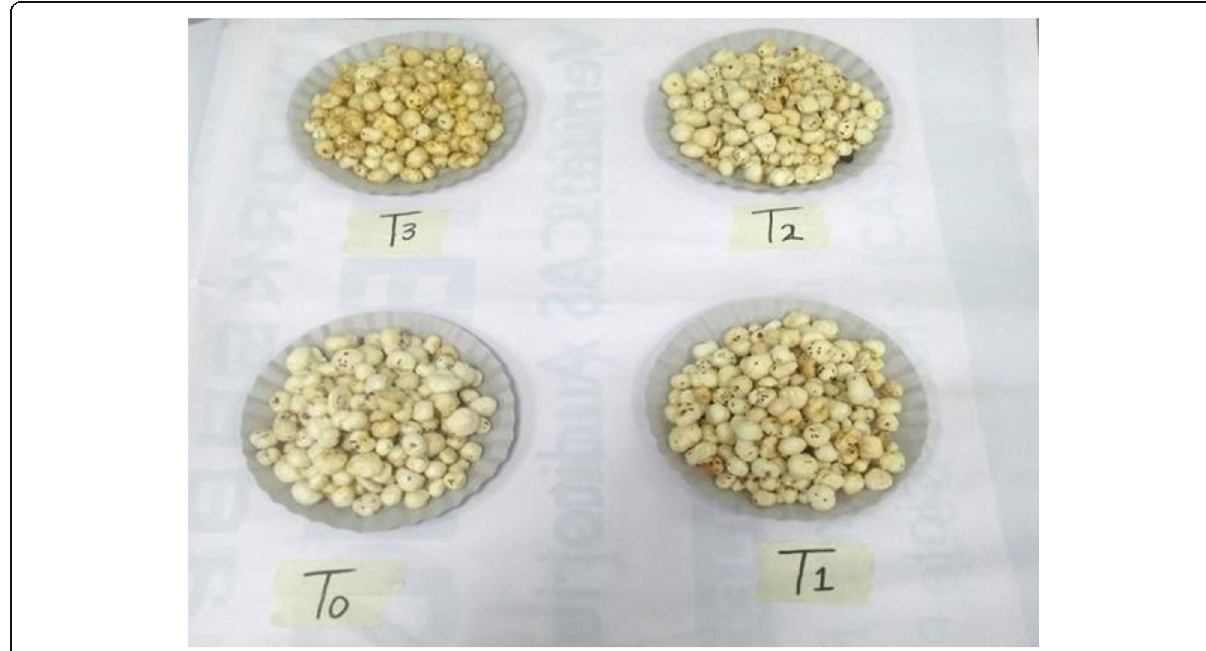
Fig. 6 Fox nuts snack treatments. T 0 = Unroasted; T 1 = Plain roasted; T 2 = Salt roasted; T 3 = Spice roasted